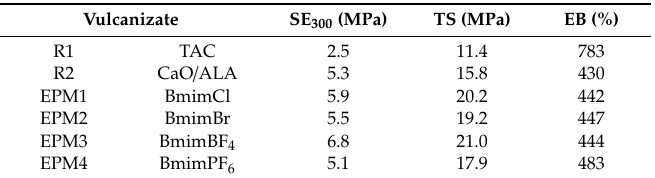
Table 8. Mechanical properties of silica-filled EPM vulcanizates (SE 300 —modulus at a relative elongationof300%, TS—tensilestrength, EB—elongationatbreak, standarddeviations: SE 300 ± 0.6 MPa, TS ± 1.4 MPa, EB ± 18%).